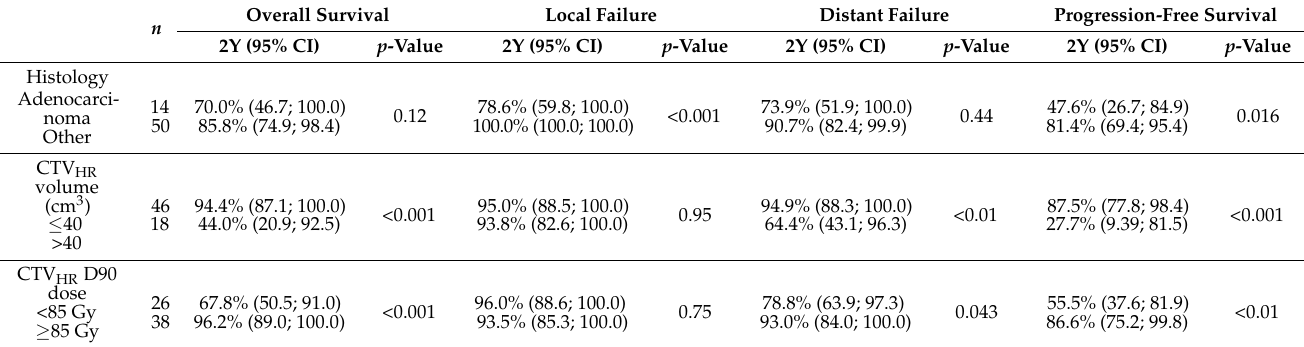
Figure 1. Kaplan ‐ Meier survival curves for ( a ) Local control (LC), ( b ) Metastatic control (MC) and ( c ) Overall survival (OS) of 64 women with locally advanced cervical cancer (LACC) treated with image ‐ guided adaptive brachytherapy (IGABT) after initial radiation therapy in the French overseas. Univariate models were fit to determine the OS, local failure, distant failure and PFS associated with histology, 18-FDG PET/CT use, FIGO stage, concurrent CT, CTV HR volume, D 90 CTV HR , and OTT. In univariate analysis, no impact of OTT or of time interval between EBRT and brachytherapy initiation was observed. Local control was poorer among patients with adenocarcinoma histology, with 2-year local control of 78.6% versus 100% for squamous cell carcinoma ( p < 0.001) (See Table 2). Table 2. Univariate analyses of factors predicting for outcomes (Kaplan Meier estimates). Only factors reaching significance ( p < 0.05) are reported.